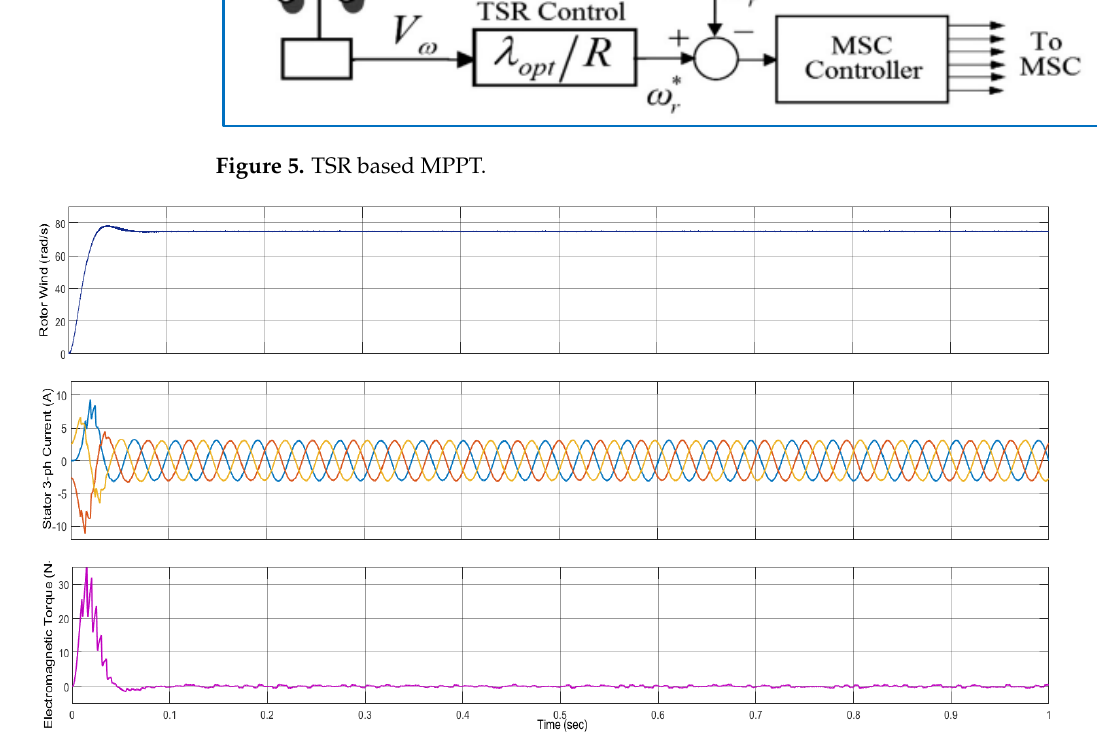
Figure 6. Simulation results of the